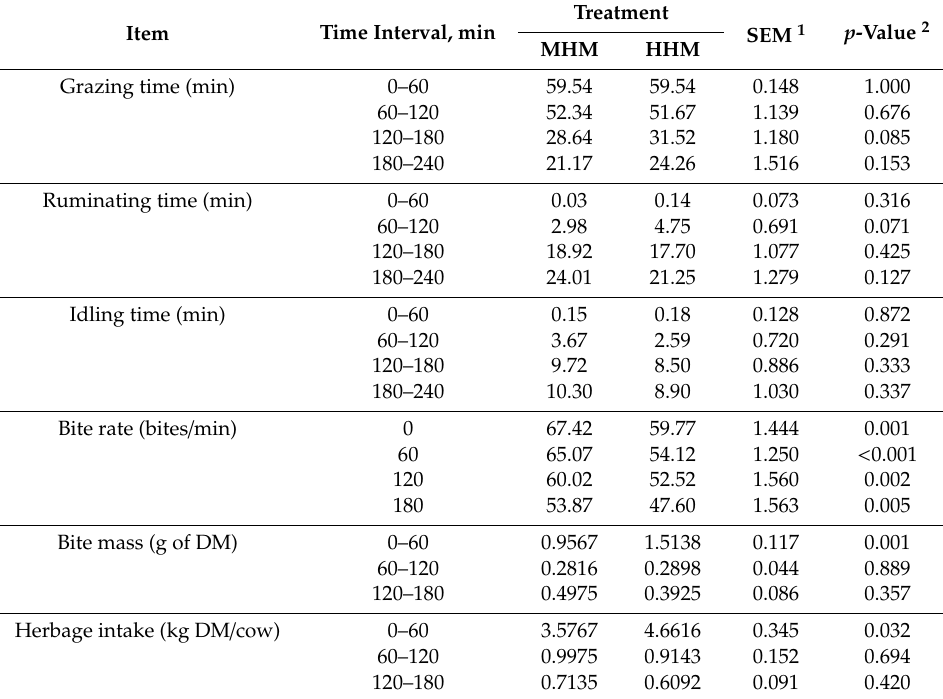
Table 3. E ff ect of medium (MHM) and high (HHM) pre-grazing herbage mass on grazing behavior, bite rate, bite mass, and herbage intake of dairy cows during the first grazing session.